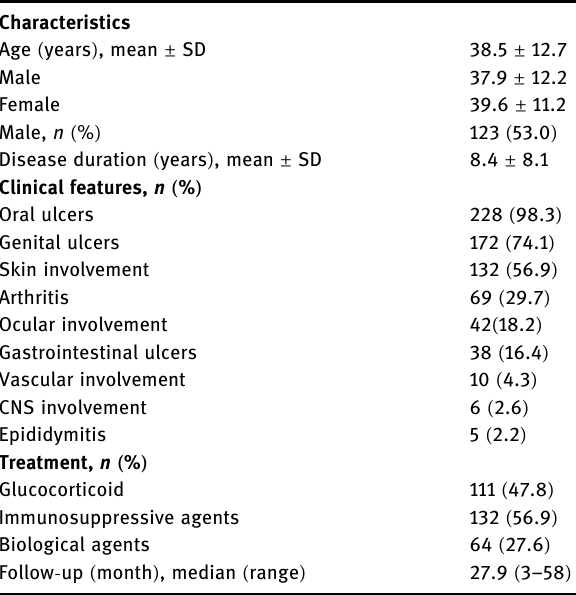
Table 1: Characteristics of the 232 hospitalized patients with BD